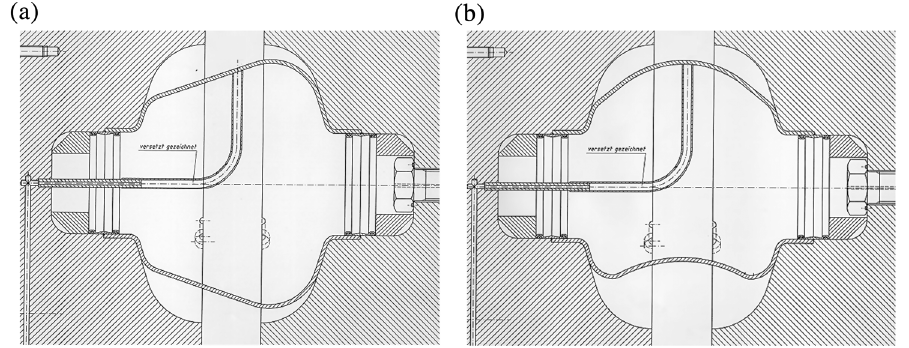
FIG. 13. (a) Conical anomaly of intermediate tube shape. (b) Anomalous tube shape for circumferential variation of yield